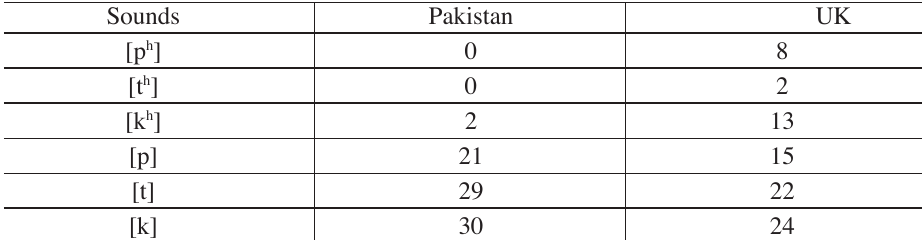
Table 4: Number of participants within native-like VOT